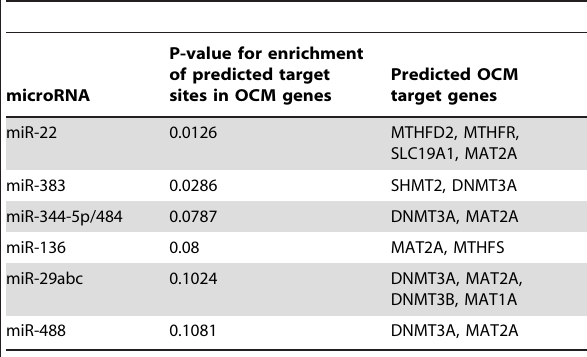
Table 2. Top 6 candidate microRNA master regulators of one- carbon metabolism genes in mammals.